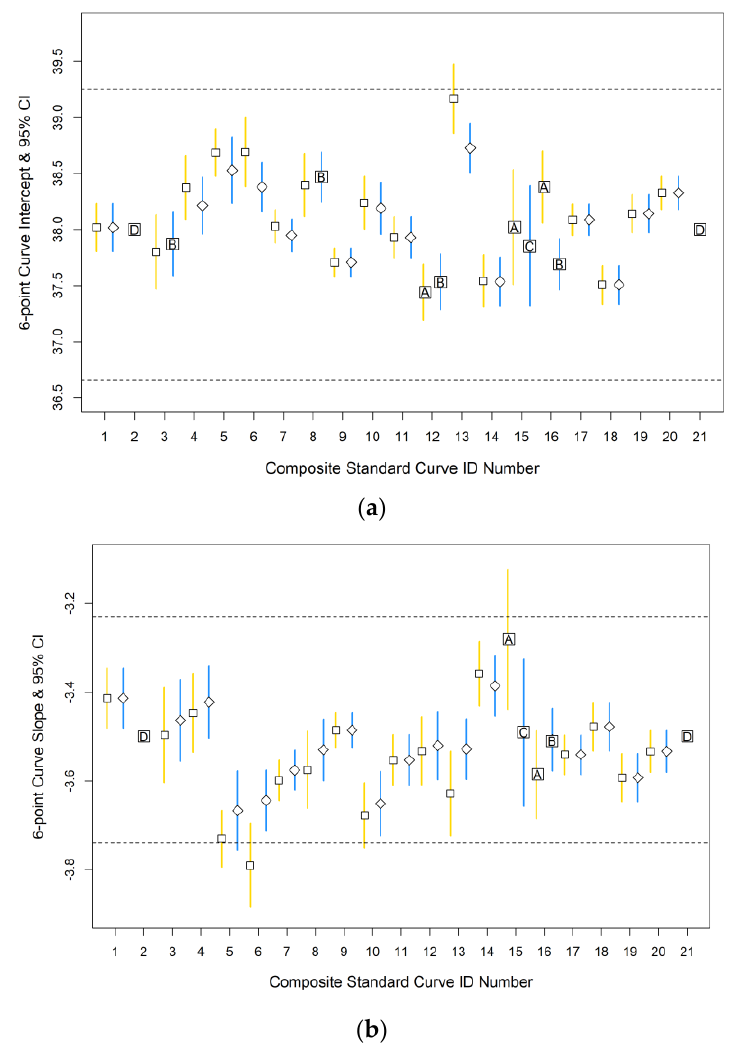
Figure 4. Mean 6-point composite standard curves intercept and slope estimates and 95% (confidence intervals) CIs. ( a ) Mean intercept; and ( b ) Mean slope estimates before data screening (open squares with gold lines) and after (open diamonds with blue lines). Vertical lines represent 95% CIs. Horizontal dashed lines represent the standard curve acceptance criteria range. Boxes with an inset ‘A’ show individual standard curves without acceptance criteria enforced that did not pass the ANCOVA therefore a composite curve value would not be calculated; the box with an inset ‘B’ shows individual standard curves that were screened with acceptance criteria and failed the analysis of covariance (ANCOVA); the box with an inset ‘C’ indicates an insufficient number of passing individual standard curves to generate a composite curve; and boxes with an inset ‘D’, no data was collected.